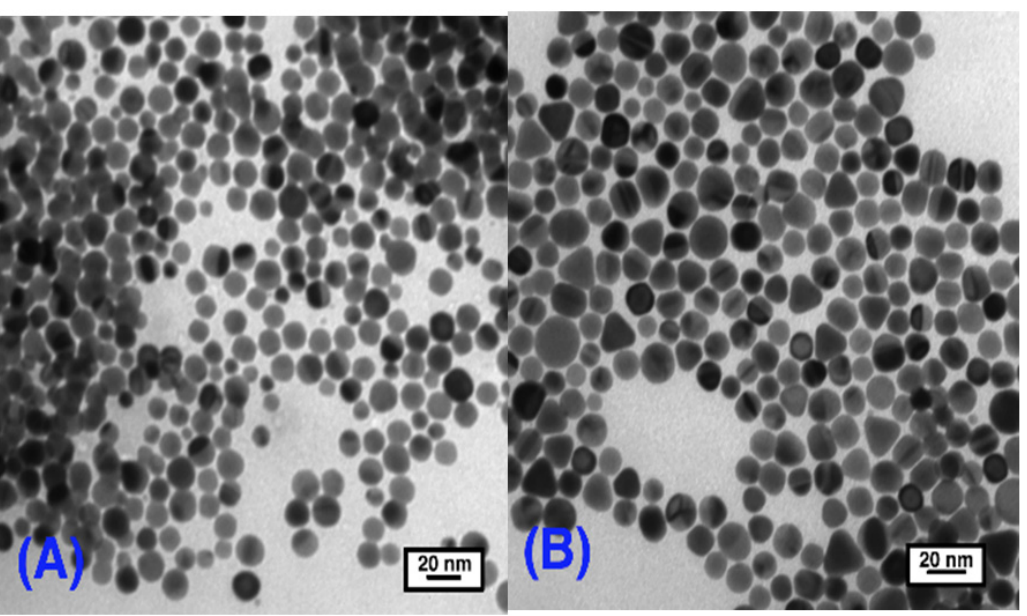
Figure 6. TEM images of ( A ) as prepared Au-octylamine colloid in toluene by inverse micelle method; and ( B ) Au-octylamine colloid after digestive ripening 2 h in toluene.